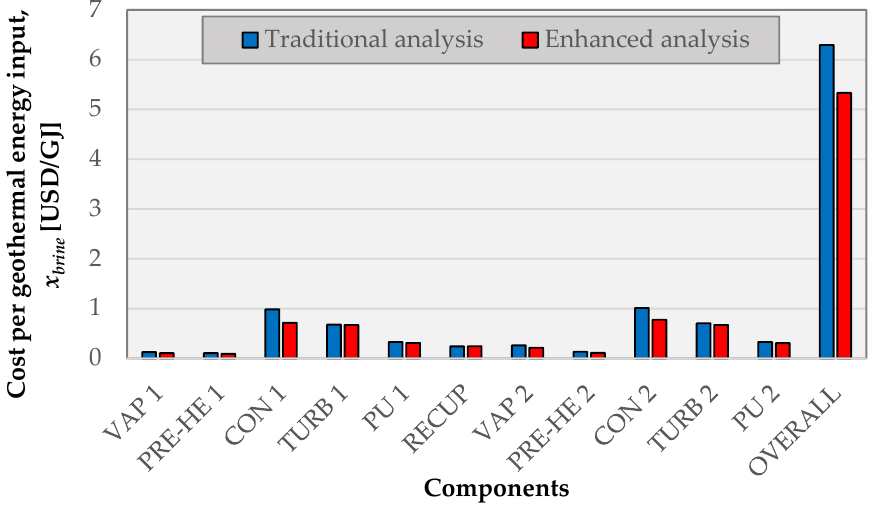
Figure 8. Change in cost per geothermal energy input for the components for both analyses.